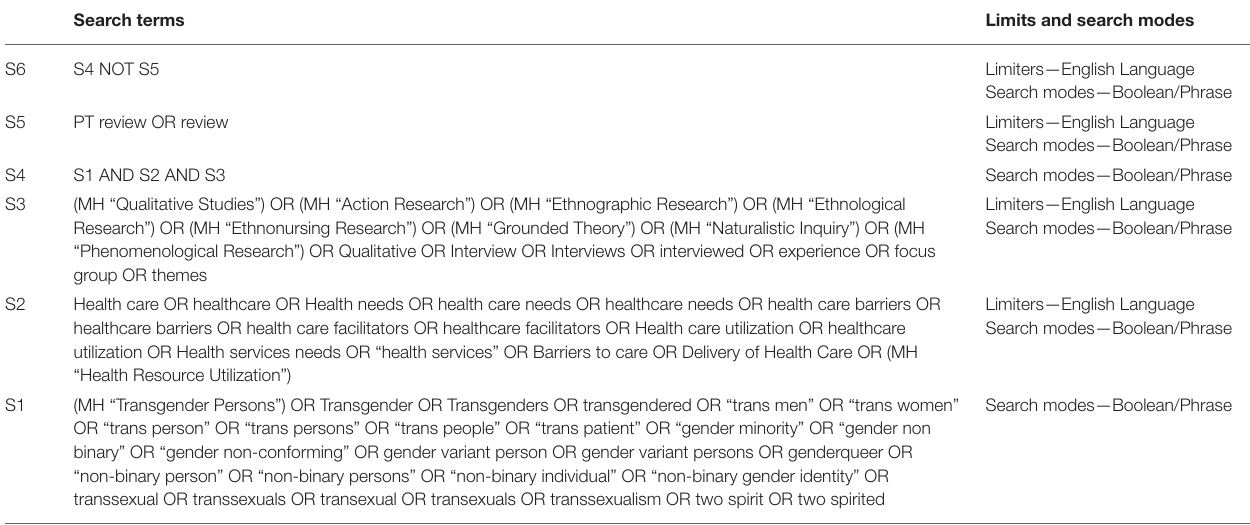
TABLE 1 | Search strategy: CINAHL